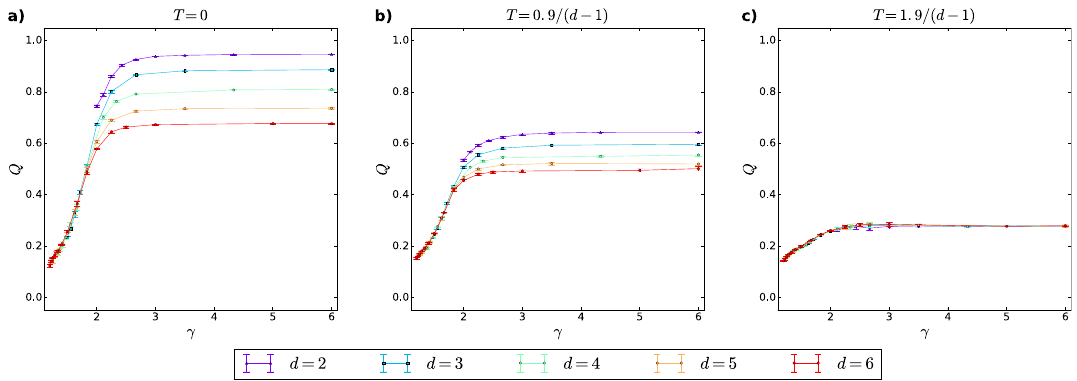
Figure 6. The highest modularity Q achieved between the asynchronous label propagation, the Louvain and the Infomap algorithms in d PSO networks as a function of the degree decay exponent γ at different values of the temperature T and the dimension d . The panels a – c refer to different values of the temperature T , given in the title of the subplots. The curves of different colours correspond to different number of dimensions d , as 1 listed below the panels. The popularity fading parameter was calculated as β 1 ) 1 ) . We always set the ( d (γ = − · − 1 , the network size N to 10, 000 and the expected average degree ζ 2 of the hyperbolic space to curvature K = − − 2 m to 10. We searched for communities once with all three community detection methods on 5 d PSO networks and plotted the obtained highest modularity averaged over the 5 networks for each parameter setting, with the error bar indicating the standard deviation among the 5